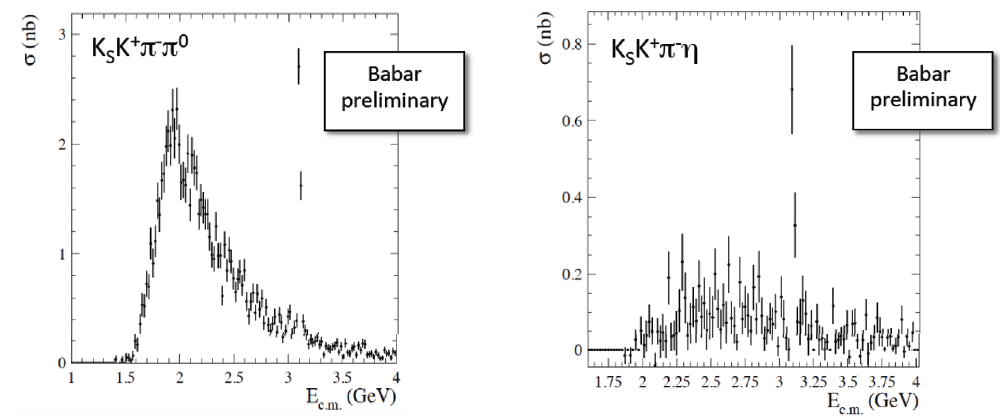
Figure 4. Babar measurements of the (left) e + e − → K S K + π − π 0 and (right) K S K + π − η cross sections.